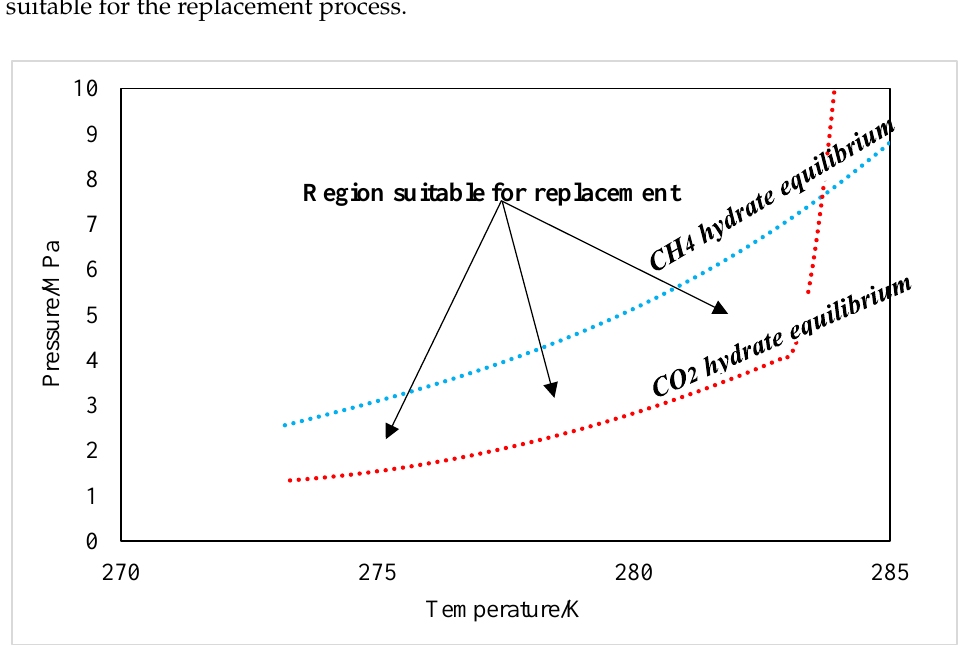
Figure 1. Phase boundary equilibrium for methane and carbon dioxide hydrates. The difference between these conditions favors the existence of a narrow thermodynamic region suitable for the CO 2 /CH 4 replacement process [35].